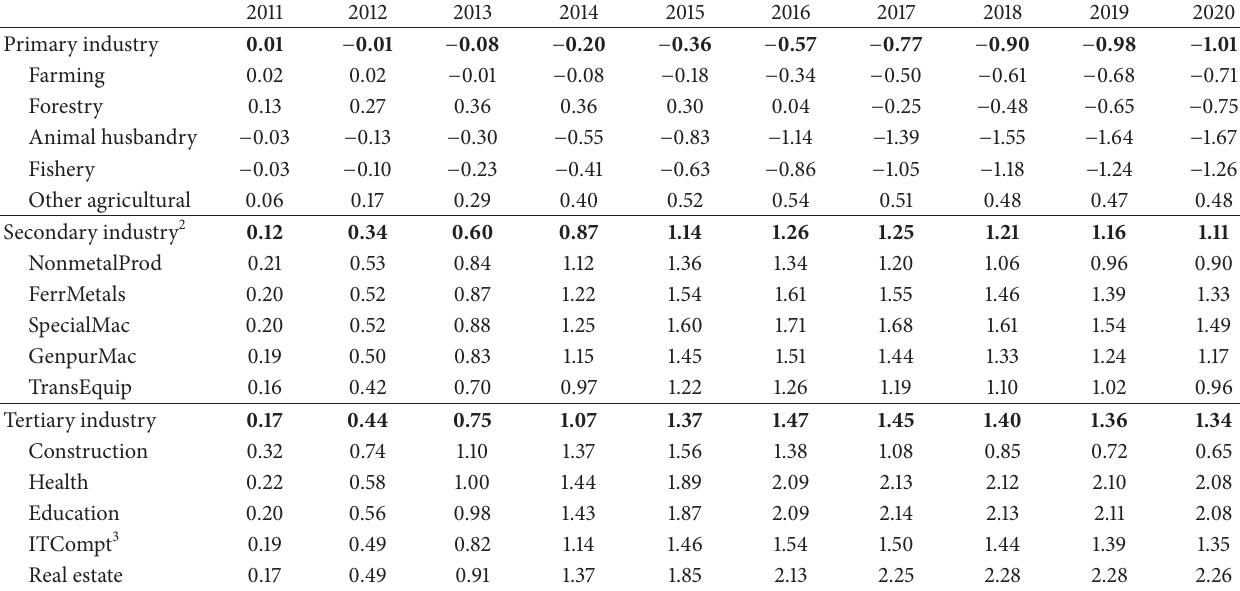
Table 4: The output of industry in 2011–2020 (% change deviation from baseline).